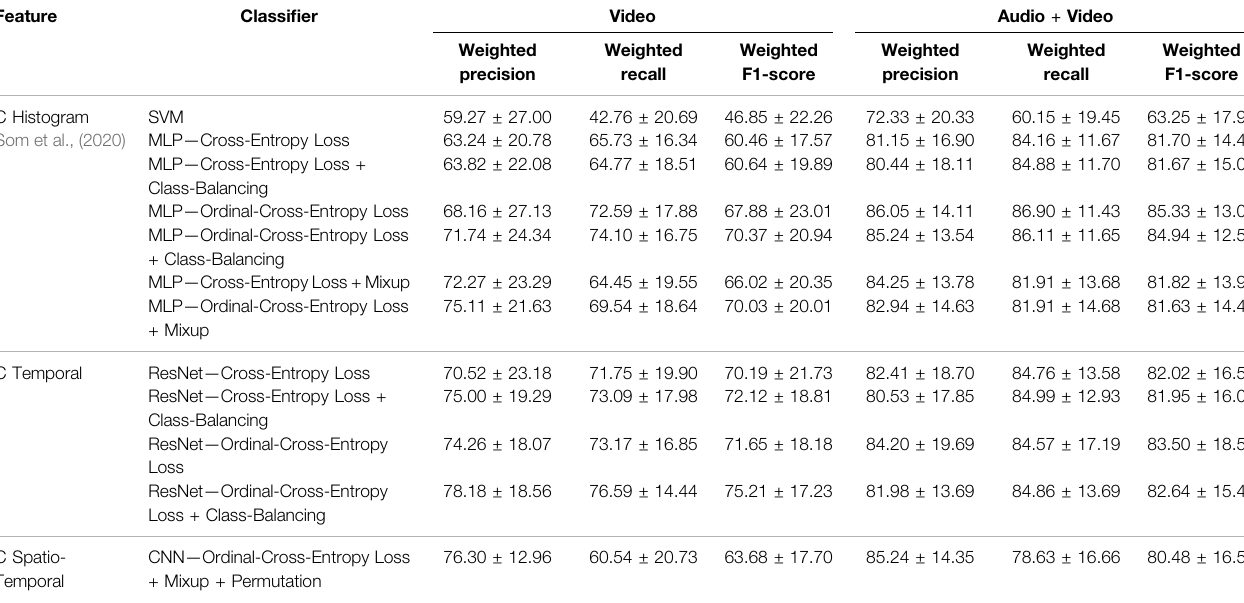
TABLE 4 | Weighted precision, weighted recall and weighted F1-score Mean ± Std measurements for the best MLP, ResNet and 2D CNN models under different settings. These models were evaluated on different feature representations extracted for Level C.